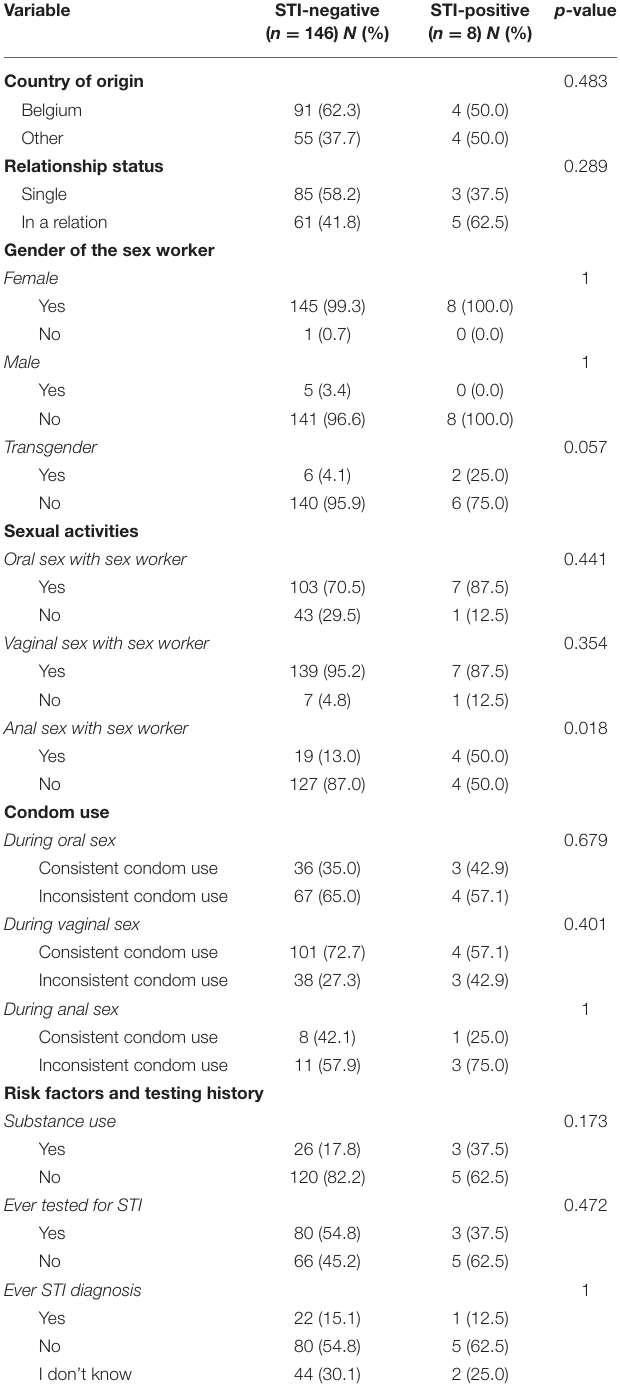
TABLE 3 | Univariate analysis of relevant variables with STI-test result as dependent variable.